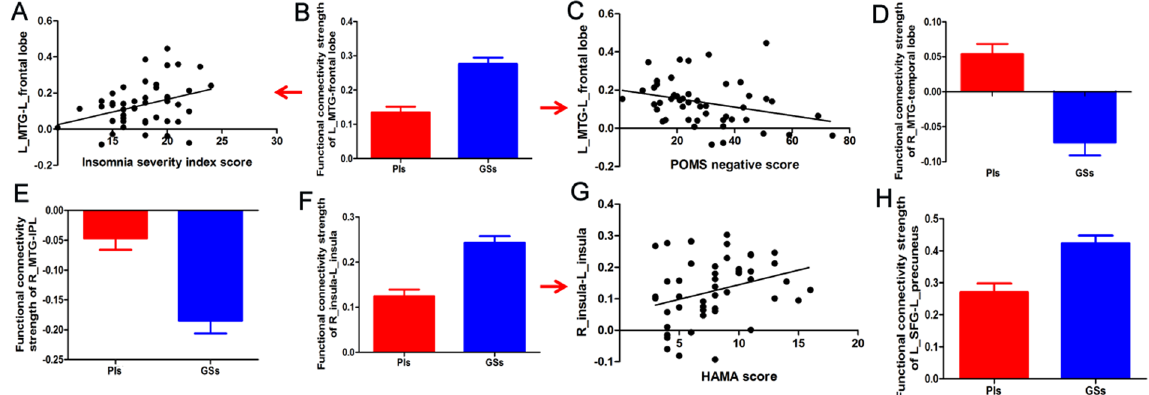
Figure 8. Binarized functional connectivity strength of between-group differences and their correlations with behavioral performances in PIs. Note: Data are mean ± standard error values. Abbreviations: R, right; L, left; MTG, Middle temporal gyrus; POMS, Profile of mood states; PIs, Patients with primary insomnia; GSs, Good sleepers; IPL, Inferior parietal lobule; HAMA, Hamilton anxiety scale; SFG, Superior frontal gyrus.